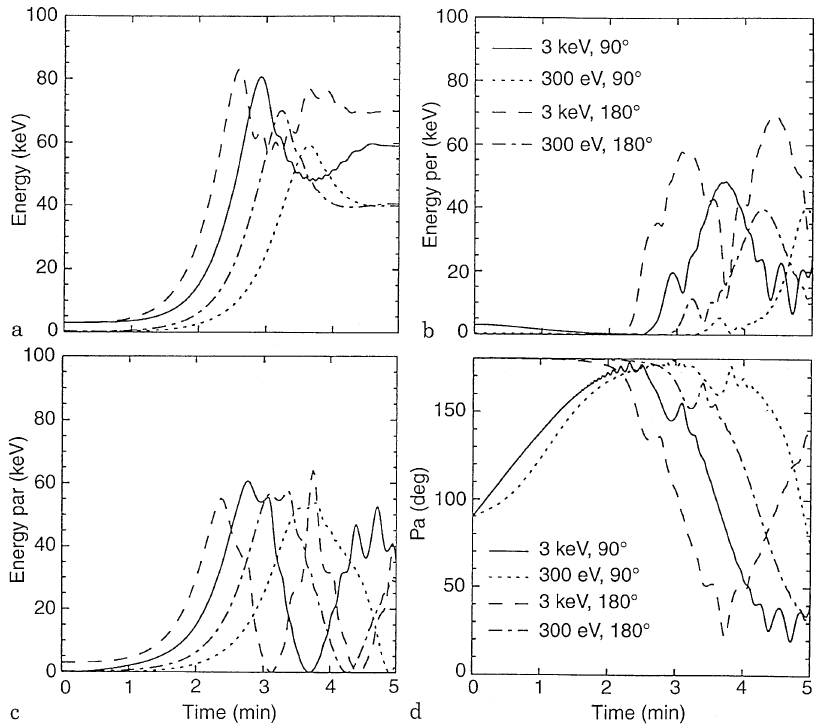
Fig. 7a (cid:177) d. The details of ions motion. a Total energy; b perpendicular energy; c parallel energy; d pitch angle versus time